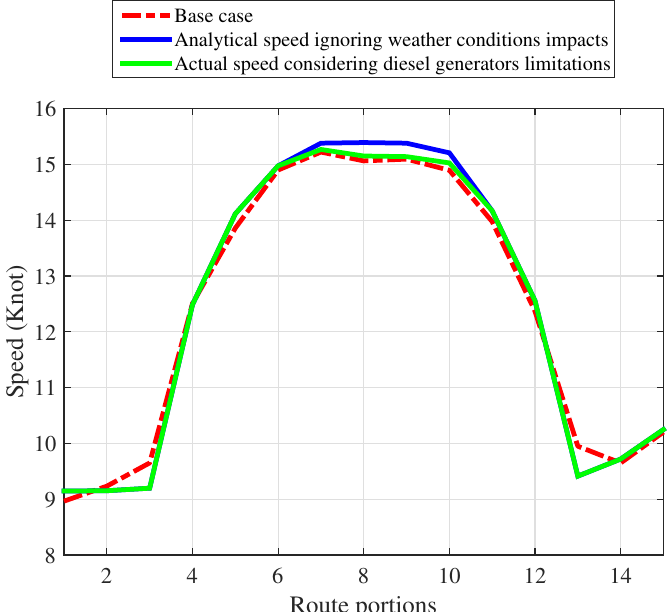
Figure 13. Comparing the speed of the ship at different portions of the route with and without considering the impacts of weather conditions.